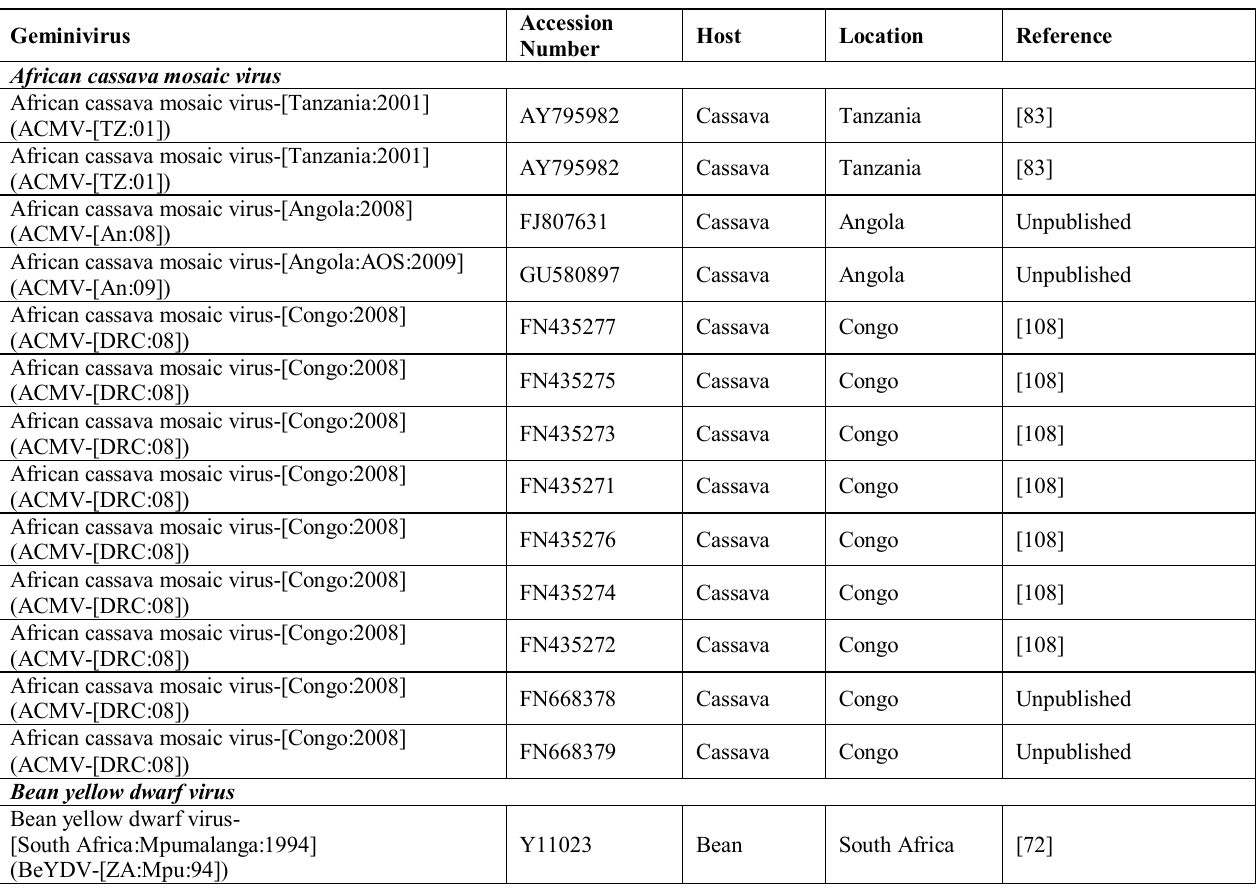
Table 1. List of mono- and bipartite geminiviruses and defective infecting subgenomic DNAs infecting dicotyledenous crops in southern and eastern Africa and south-west Indian Ocean